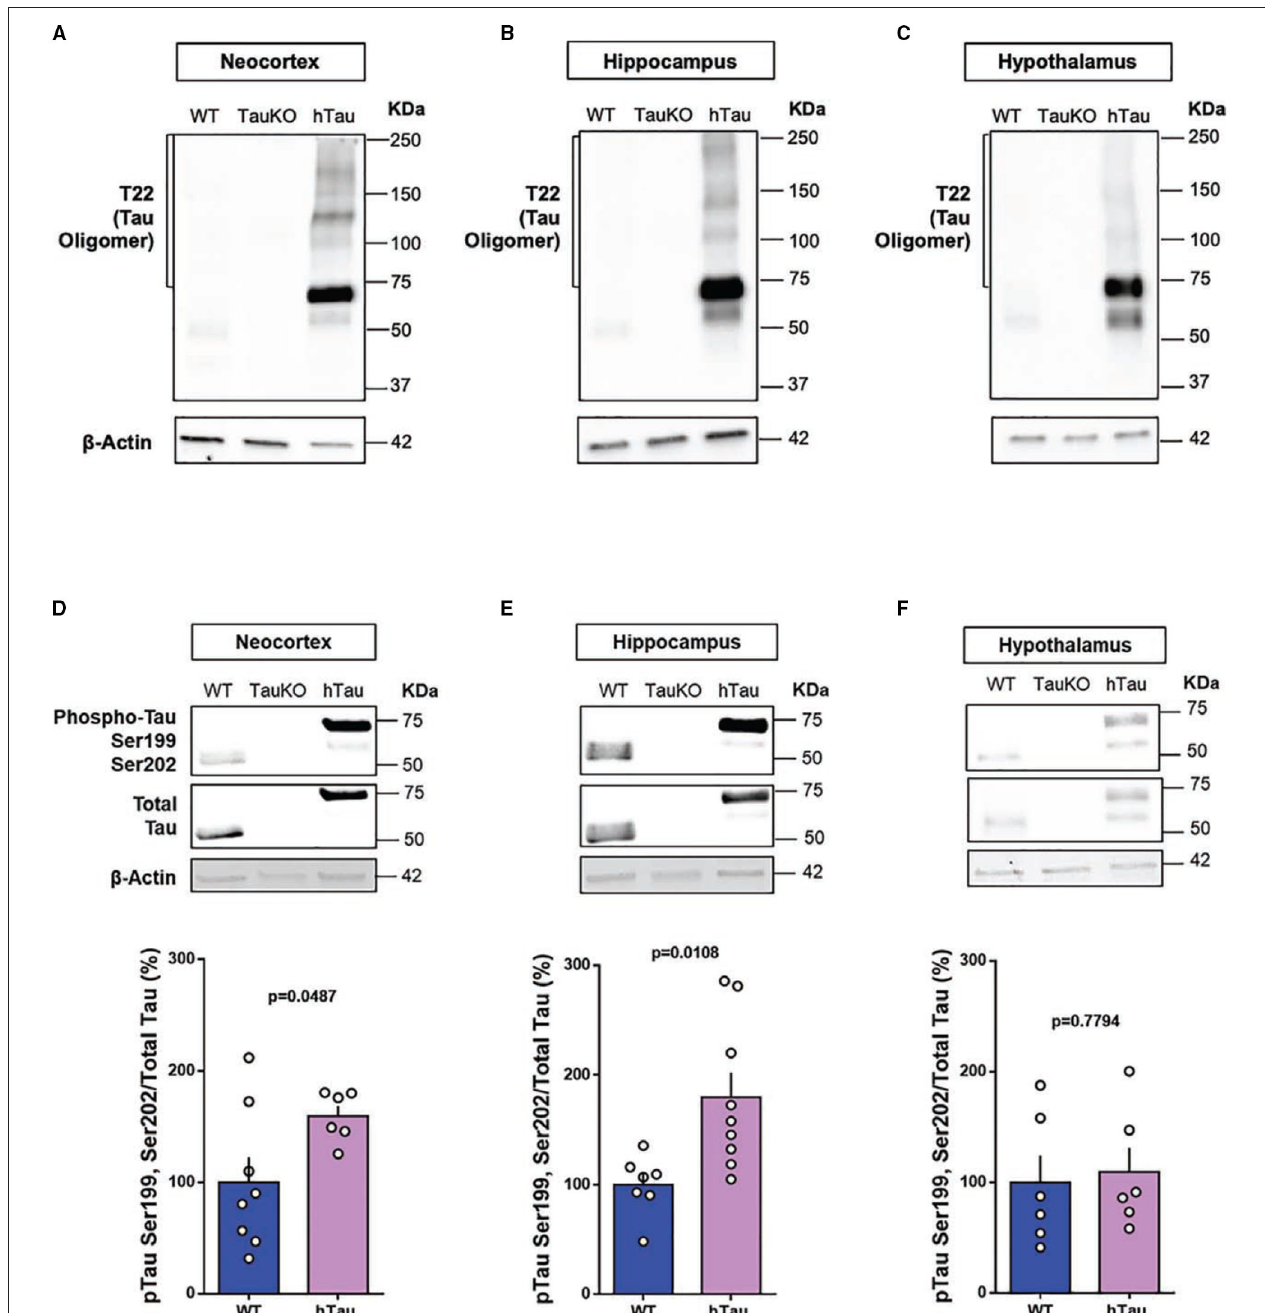
FIGURE 4 | Phospho-tau and tau oligomers are increased in multiple brain regions of hTau mice. Immunoblot analysis of tau oligomers in (A) cortical, (B) hippocampal, and (C) hypothalamic lysates from 20-week-old WT, TauKO, and hTau mice. Immunoblot analysis of pTauSer199Ser202/TotalTau ratio in (D) cortical ( n = 8 WT; 6 hTau), (E) hippocampal ( n = 7 WT; 9 hTau), and (F) hypothalamic ( n = 6 WT; 6 hTau) lysates from 20-week-old WT, TauKO, and hTau